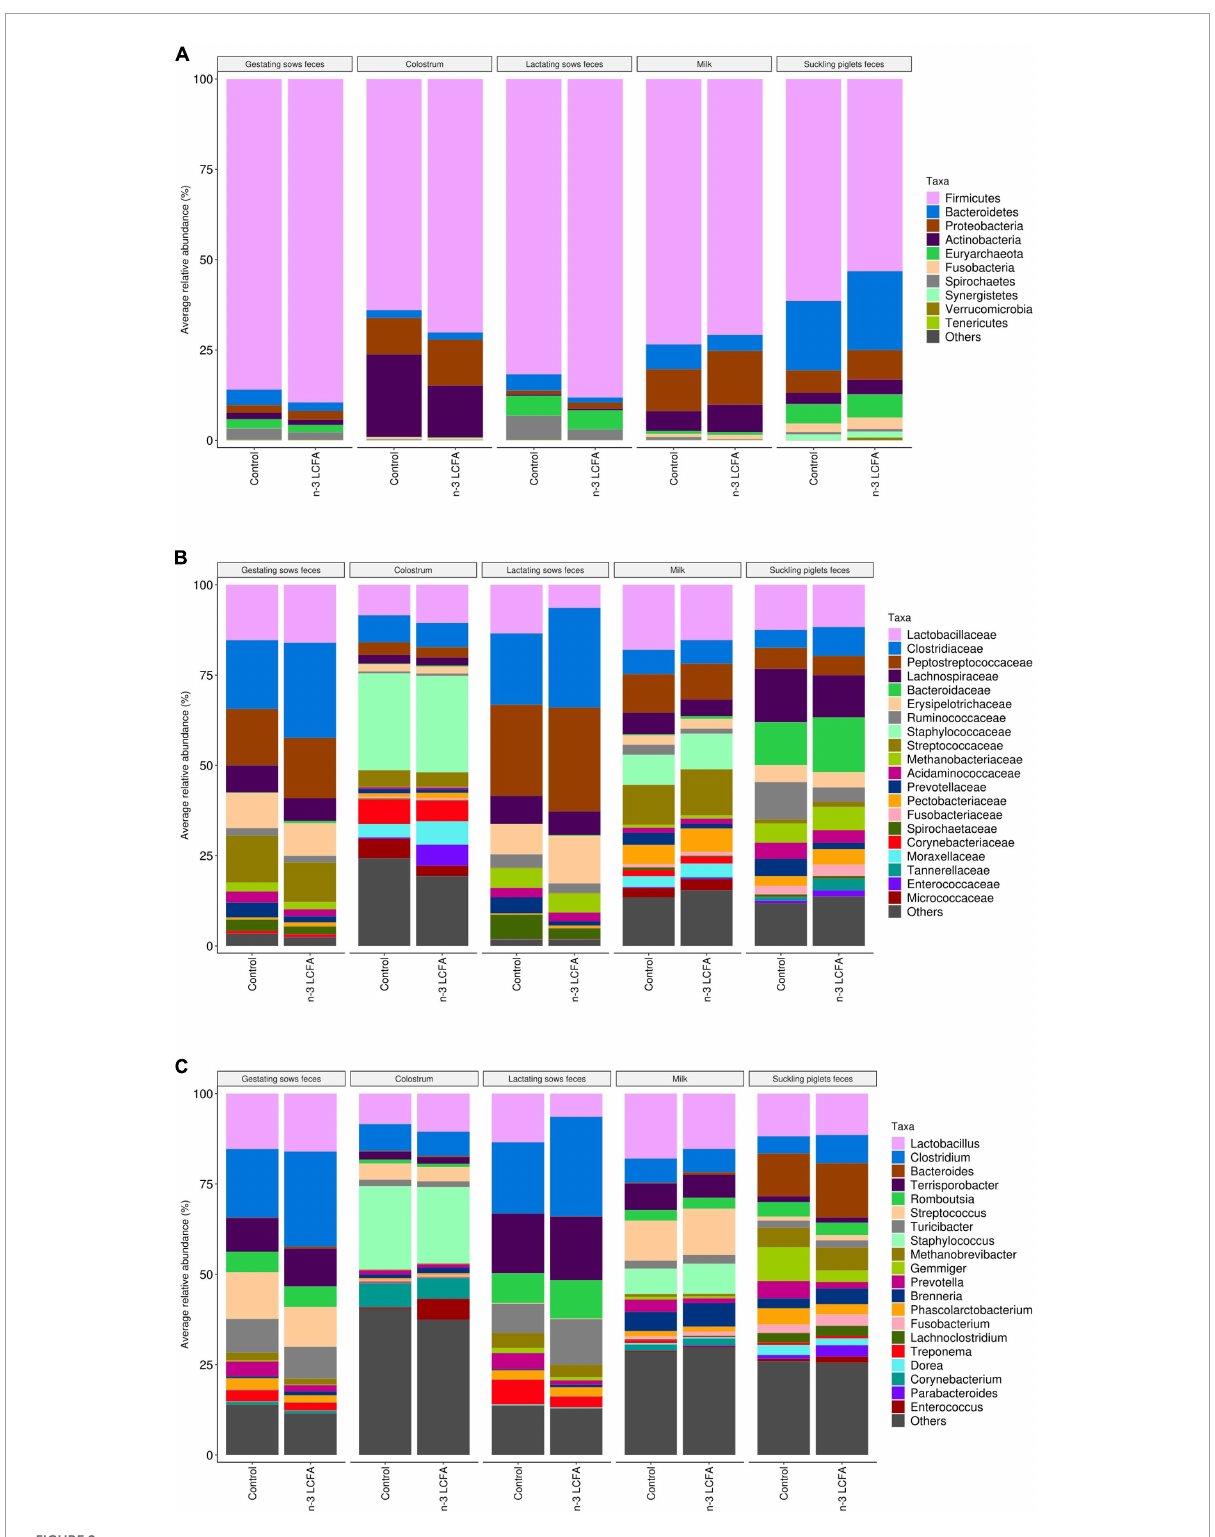
FIGURE2 Microbiota composition by the relative abundance of the top 10 phyla (A) , top 20 families (B) , and top 20 genera (C) of feces of gestating and lactating sows ( n = 21), colostrum ( n = 21), milk ( n = 21), and feces of suckling piglets ( n = 84) according to dietary treatment (control vs. n-3 LCFA). LCFA, long-chain fatty